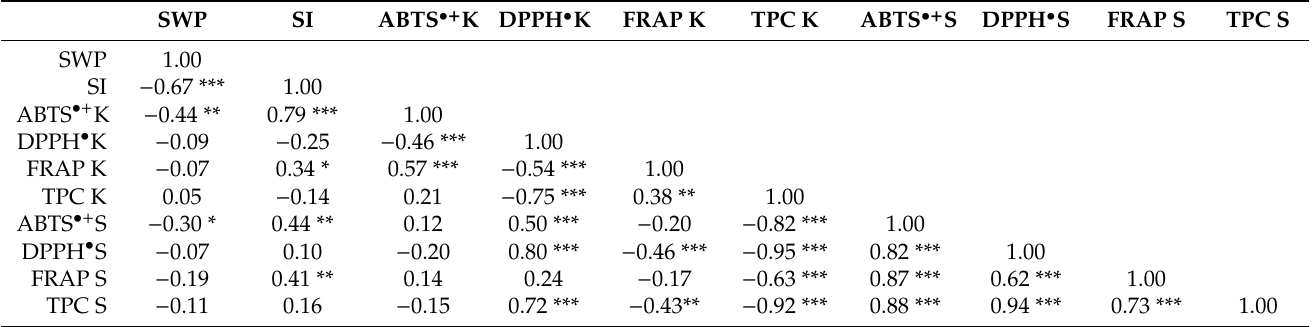
Table 3. Pearson’s correlation coe ffi cients (R) among stem water potential and stress integral with antioxidant activity of almond kernel and kernel skin.